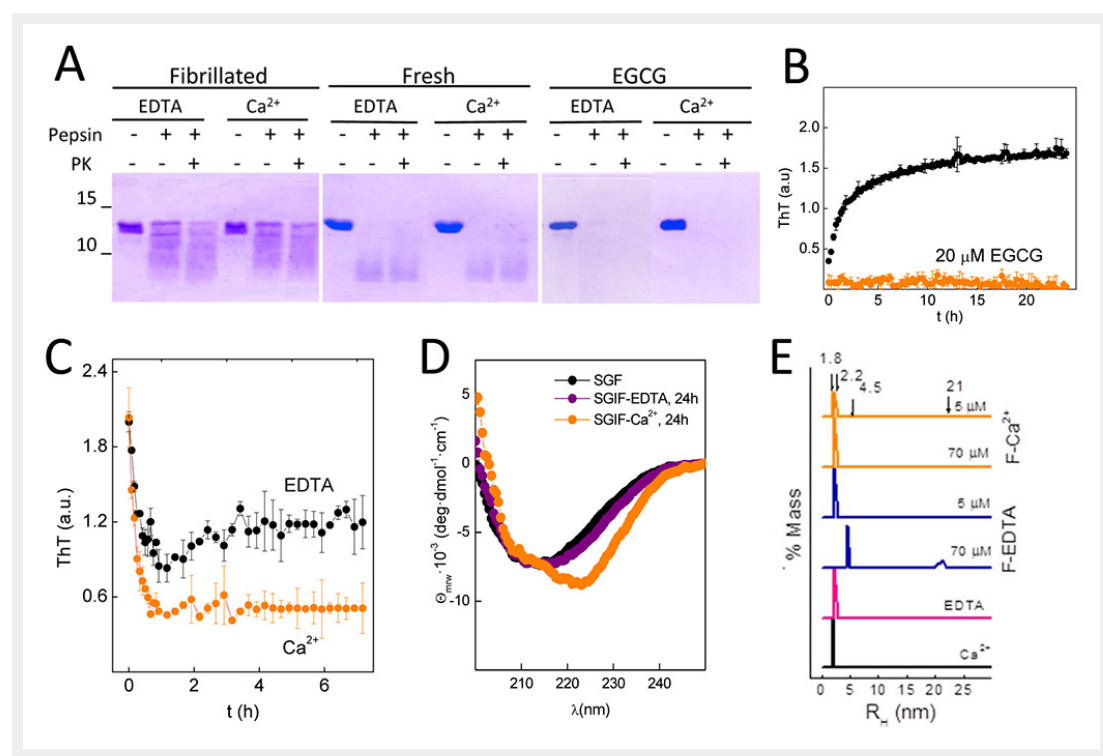
Figure 3 Amyloid fibrils protect rGad m1 from protease digestion and function as depots releasing distinct species. ( A ) sodium dodecyl sulfate polyacrylamide gel electrophoresis (SDS-PAGE) analysis of gastric (pepsin at pH 2.0) and gastrointestinal (pepsin at pH 2.0 followed by proteinase K at pH 7.4) digestions of freshly prepared solutions or after 36 h of fibrillation in SGF, in the absence and presence of 20 μM of epigallocatechin gallate (ECGC), show amyloid-assembly protects monomers from proteolysis. Gels were stained with Coomassie blue. ( B ) Incubation of rGad m 1 with ECGC (20 μM) prevents the increase in thioflavin T (ThT) fluorescence due to fibrillation. Incubation was performed for 15 min in simulated gastric fluid (SGF) and then brought to simulated intestinal fluid (SIF) conditions. Data correspond to two independent experiments performed in triplicate. ( C ) Time-course decrease of ThT fluorescence of rGad m 1 fibrils resuspended in SIF containing either 5 mM EDTA or 5 mM CaCl 2 indicates amyloid disassembly. ( D ) Evolution of the circular dichroism (CD) spectrum of rGad m1 fibrils after resuspension in SIF containing either 5 mM EDTA or 5 mM CaCl 2 reveal effects of amyloid disassembly on secondary structure. Spectra were recorded 3 h after resuspension. ( E ) DLS analysis of soluble rGad m 1 obtained in the supernatant of a 100,000 x g centrifugation of amyloid fibrils resuspended in SGF and SIF containing either 5 mM EDTA or 5 mM CaCl 2 show the release of monomers and oligomers. Species with R H of 1.8 ± 0.1 nm and 2.2 ± 0.2 nm correspond to Ca 2+ -bound and free monomers, and those with 4.5 ± 0.5 nm and 21 ± 0.5 nm to